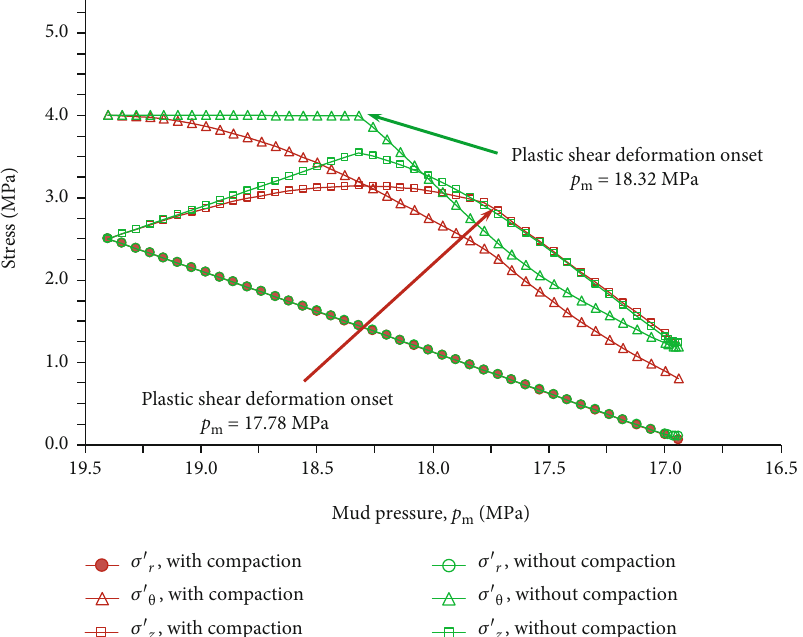
Figure 6: E ff ective stress evolution at a point on the wellbore surface during the drilling process (perfect fl ow barrier and p